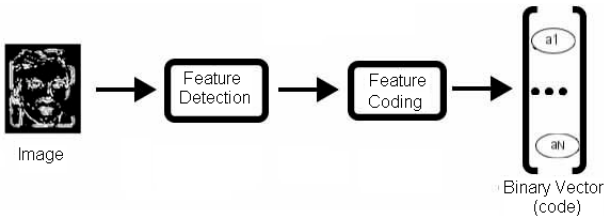
Figure 12. Feature extraction process.